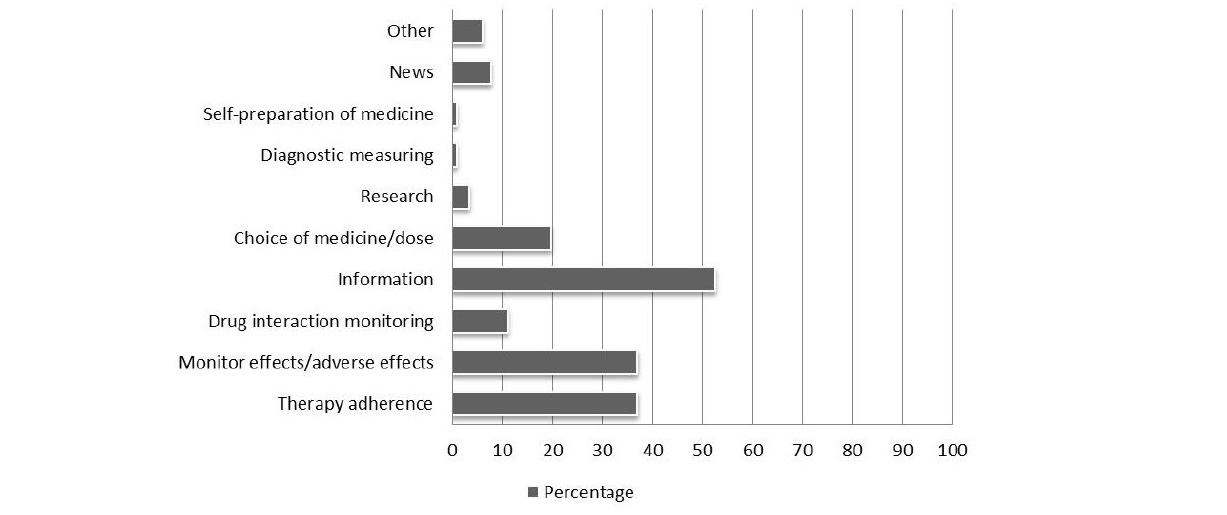
Figure 1. Functionalities of the tools. Data is presented as percentage of total number of tools (n = 116). Tools can have multiple functionalities.